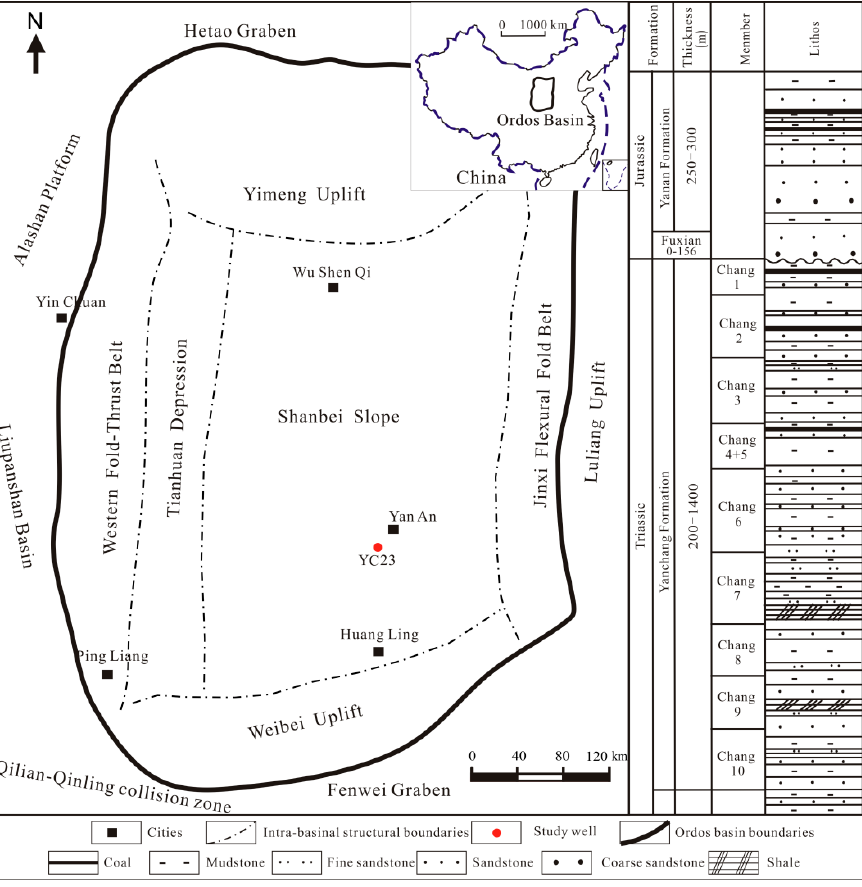
Figure 1. Map showing the stratigraphic succession of Ordos Basin and the location of the study well.